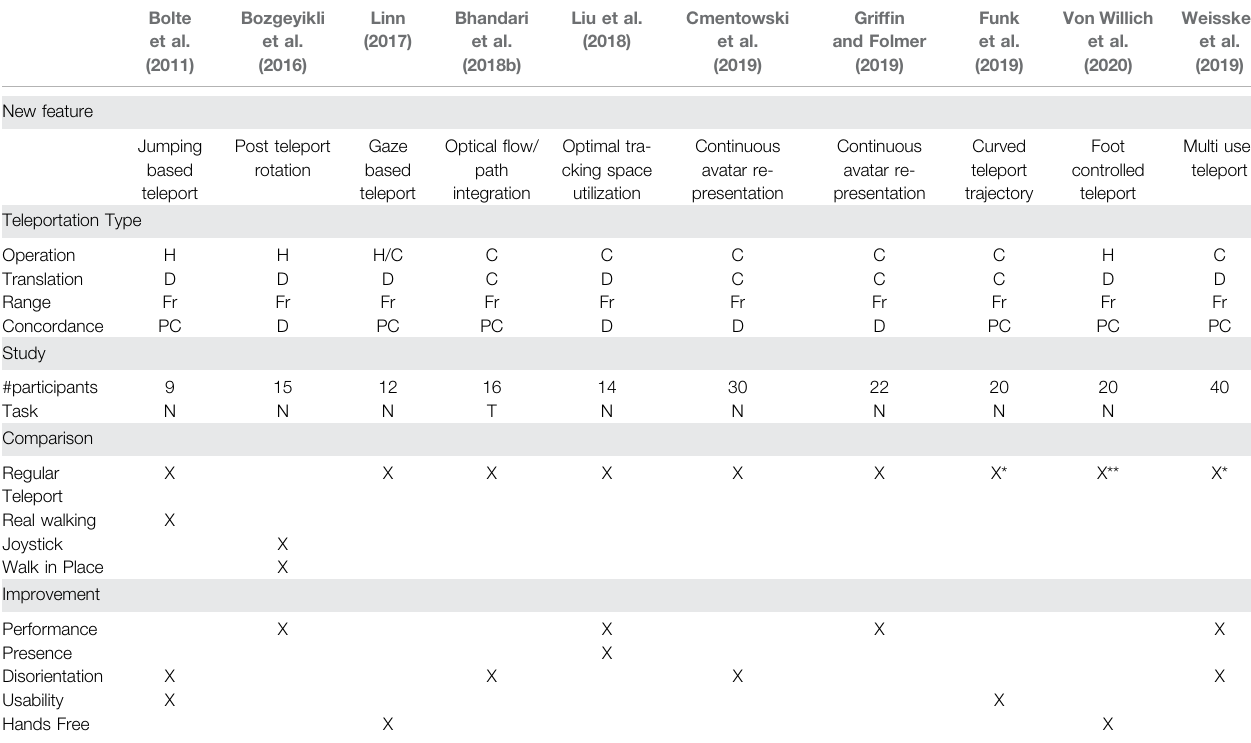
TABLE 2 | (*) Funk et al. (2019) compared two variants of curved trajectory teleport to three point and teleport variants (straight trajectory, parabolic trajectory and parabolic trajectory with angle select). (**) Von Willichet al. (2020) didn ’ t fi ndstatistically signi fi cantimprovement over point and teleport but gotgenerallyfavorable user feedback. (***) Weissker et al. (2019) compared against a natural extension of regular teleport where the whole group teleports to a new position when the group navigator uses teleport. Bolte et